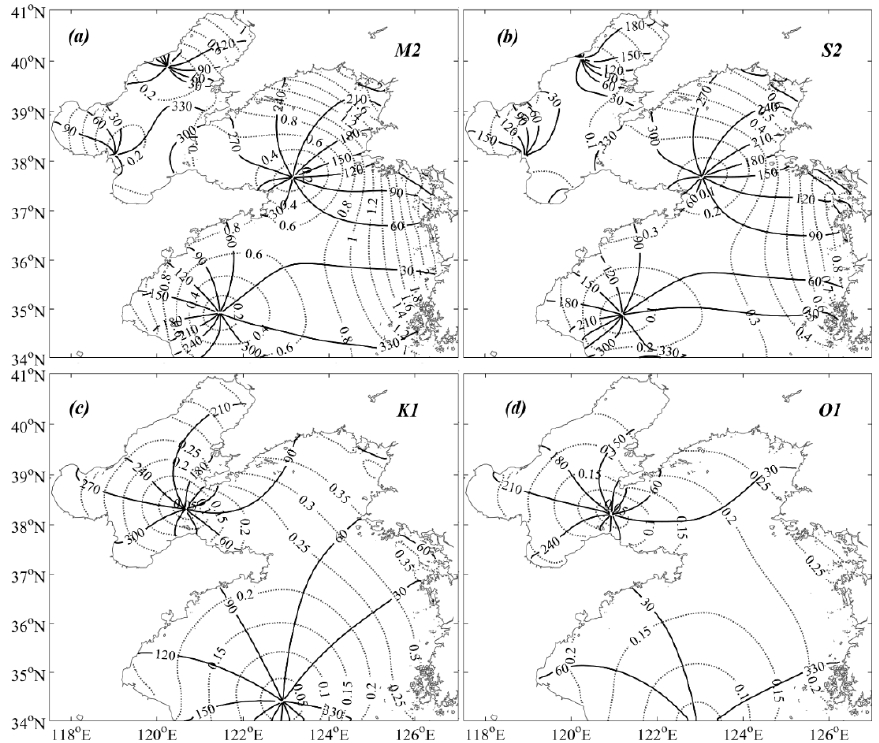
Figure 4. The cotidal chart for M 2 ( a ), S 2 ( b ), K 1 ( c ), and O 1 ( d ) in the Bohai Sea and the Yellow Sea calculated by ROMS. Solid lines represent the phase lag (in degree) and dashed lines represent the amplitude (in meters).